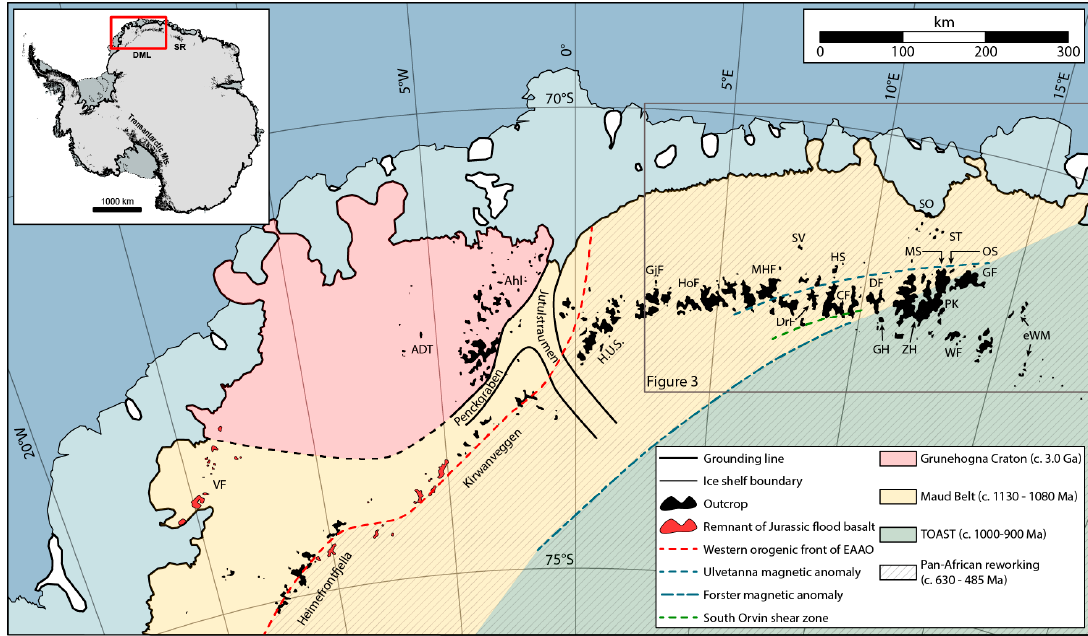
Figure 2. Simplified geological map of western and central Dronning Maud Land. Abbreviations: